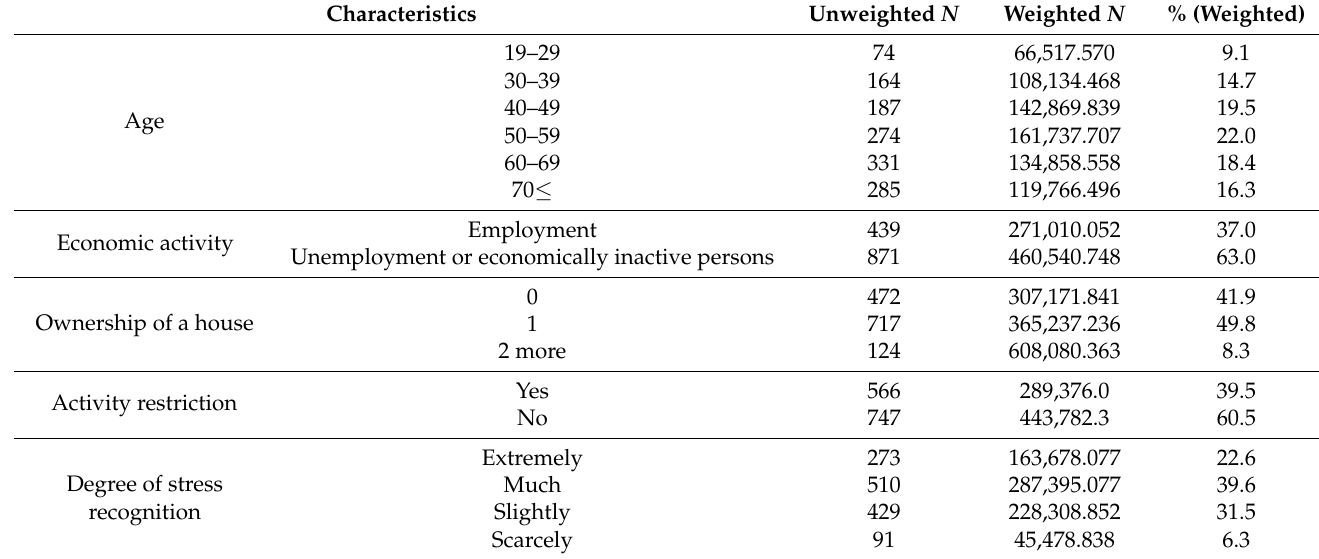
Table 1. Demographic characteristics of participants in the